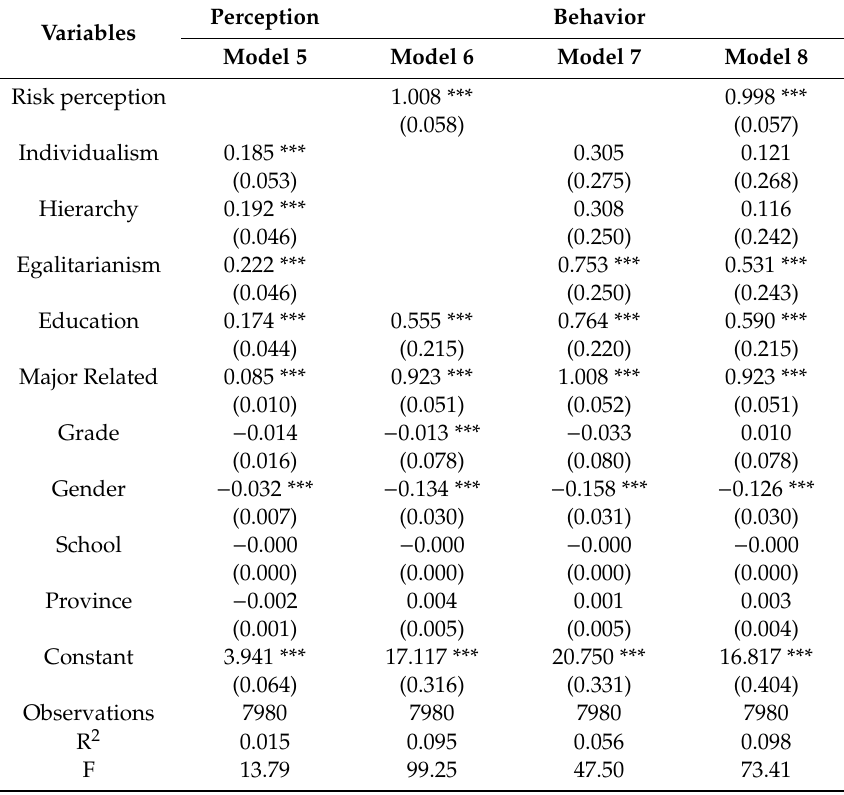
Table 7. Regression results (Dominant Risk